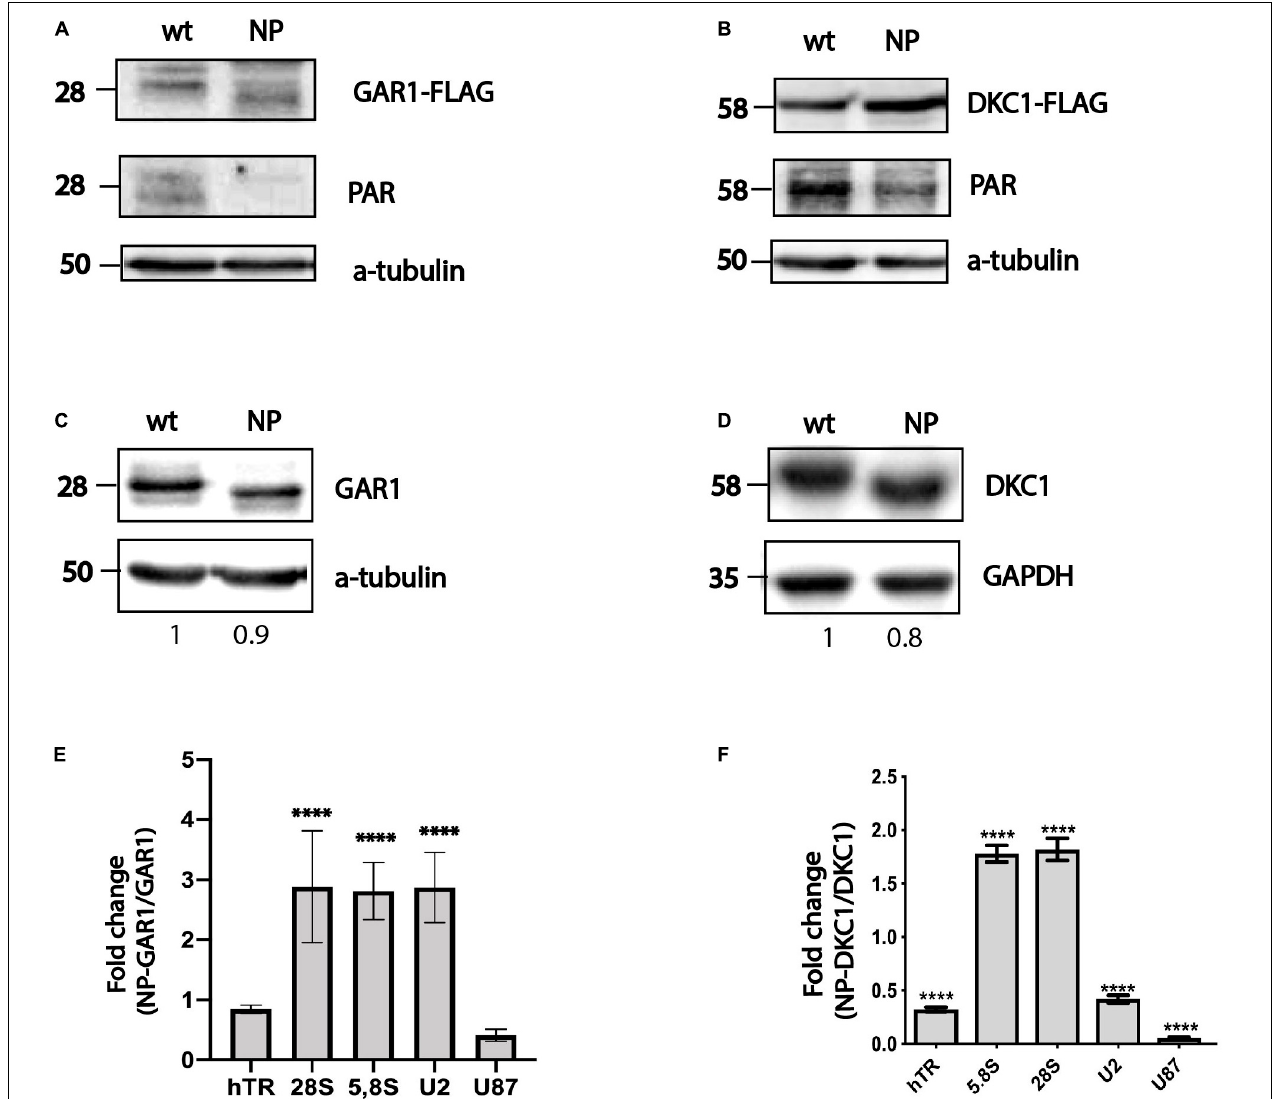
FIGURE 1 | PARylation regulates ribonucleoprotein complex stability. Substitution of amino acid residues at sites proposed for PARylation influences the PAR-attachment to GAR1 (A) and DKC1 (B) mobility of the GAR1 (A,C) and DKC1 (B,D) proteins. Differential binding of RNA to GAR1 and NP-GAR1 (E) and to DKC1 and NP-DKC1 (F) , as revealed by RT-qPCR analysis. The mean values were calculated from triplicate RT-qPCR experiments with three biological replicates, and the bars represent SE. ∗∗∗∗ P < 0.0001 by Šidák’s multiple comparisons